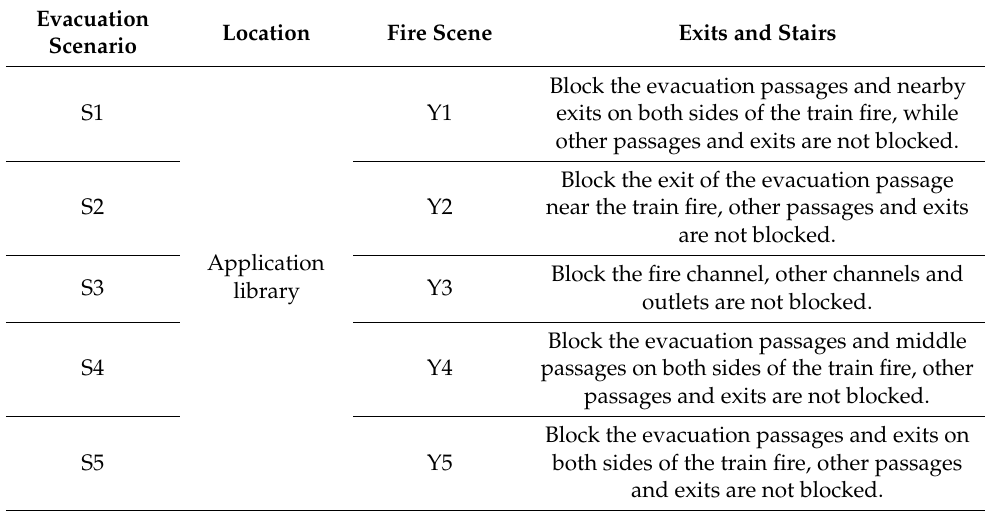
Table 10. Evacuation scenario